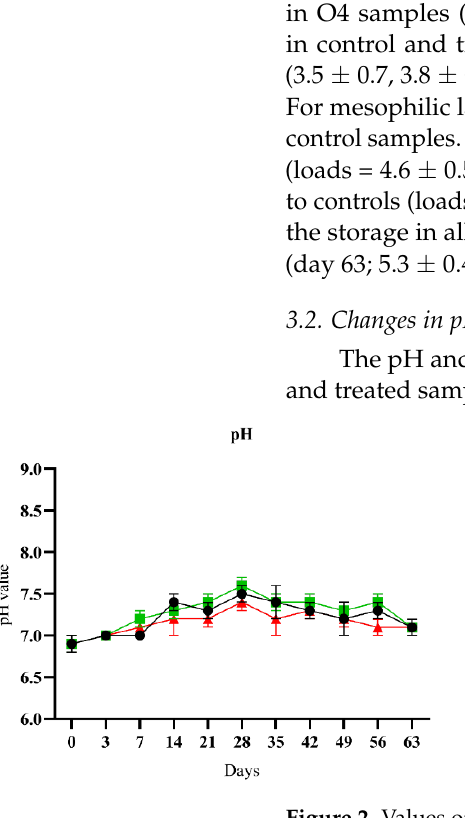
Figure 2. Values of pH and a w in control and ozone-treated (O2 and O4) rind samples during storage at 4 °C. Error bars indicate the standard deviation between three